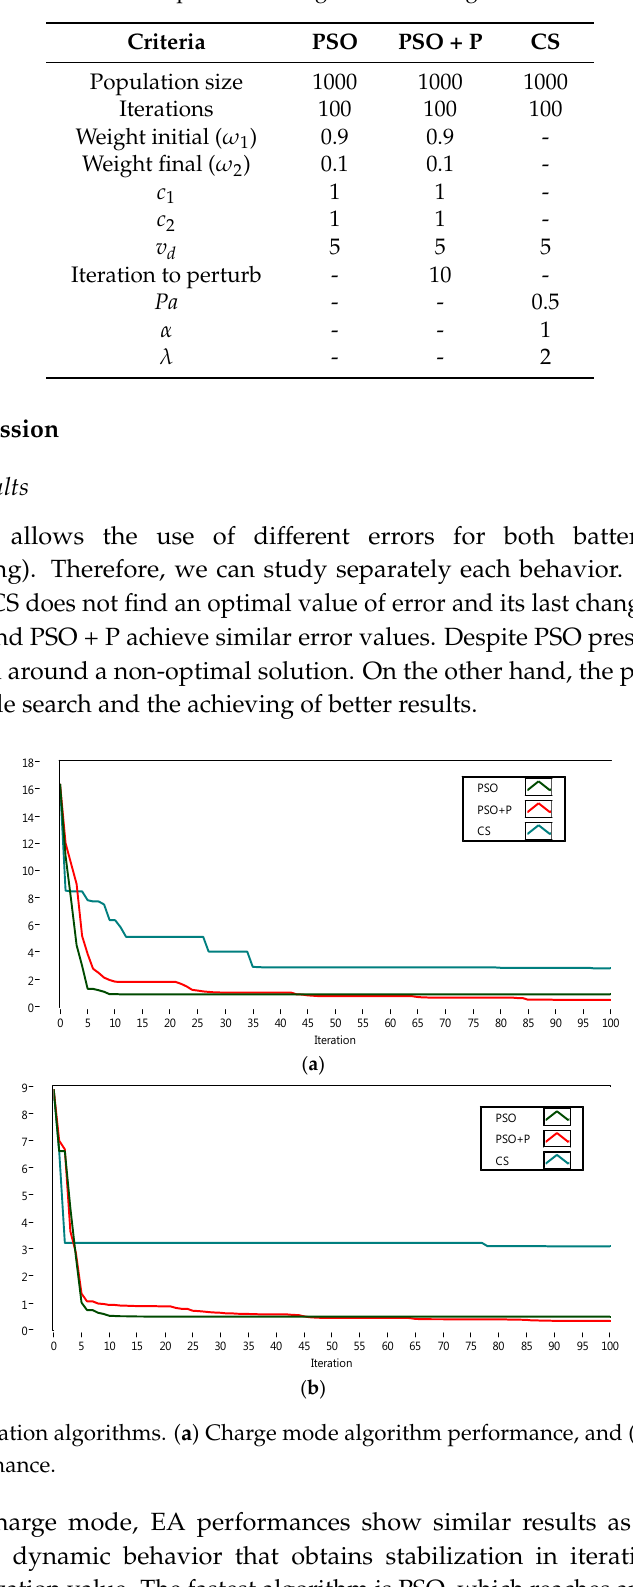
Table 2. Optimization algorithms’ configurations.